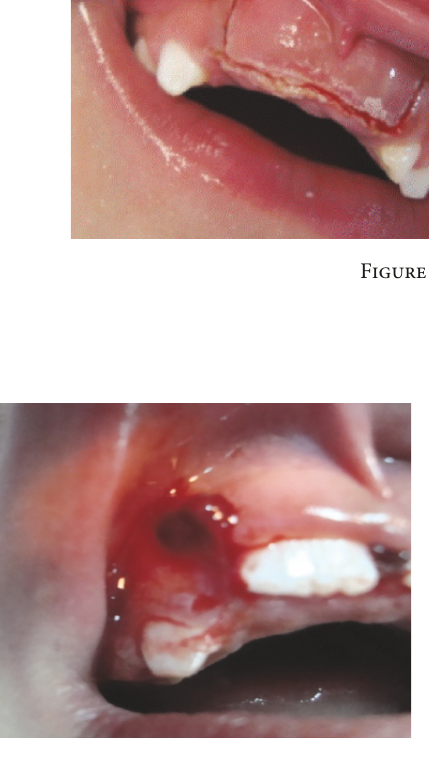
Figure 3: 3-day postoperative view. The right suture was removed. The wound was resutured.